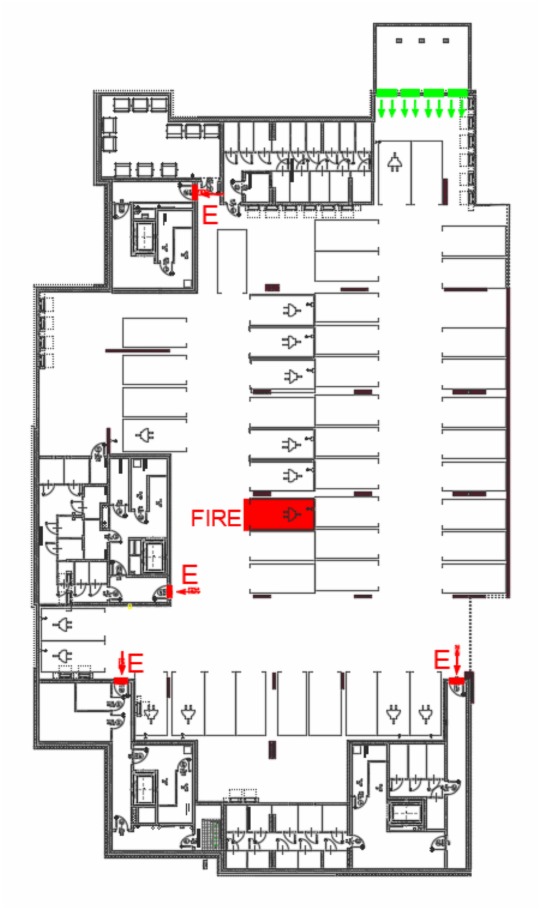
Figure 5. Scheme of the car